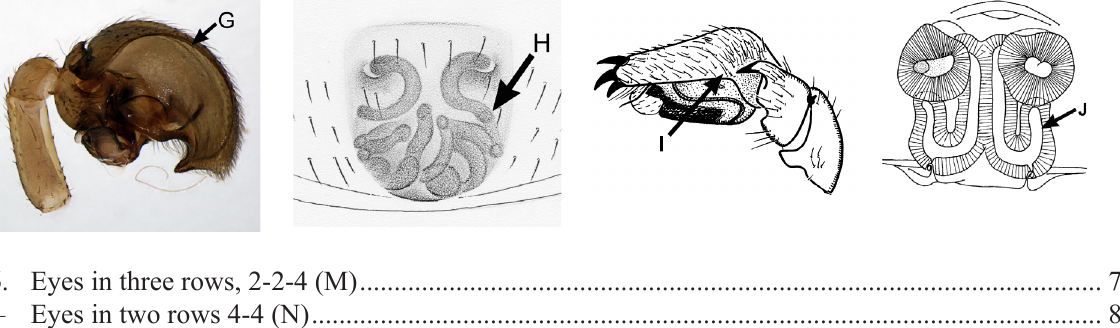
Eyes in three rows, 2-2-4 (M) ............................................................................................................ 7